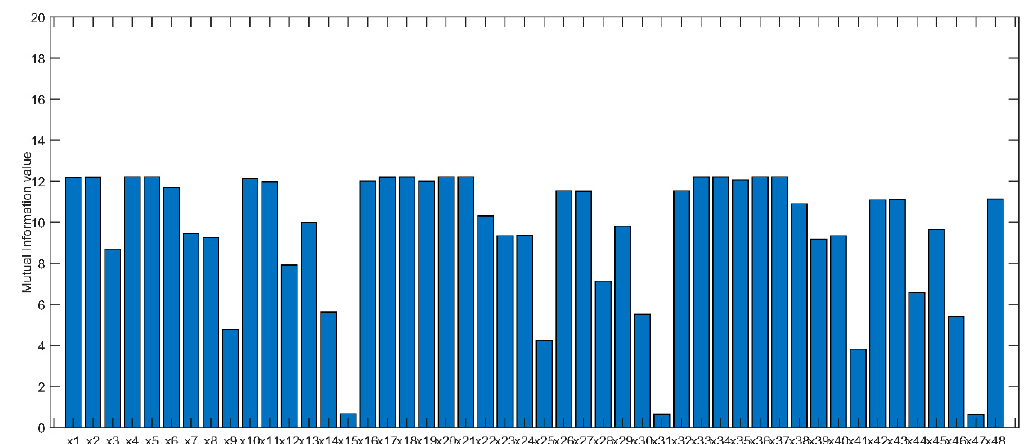
Figure 3. Mutual information of all variables.